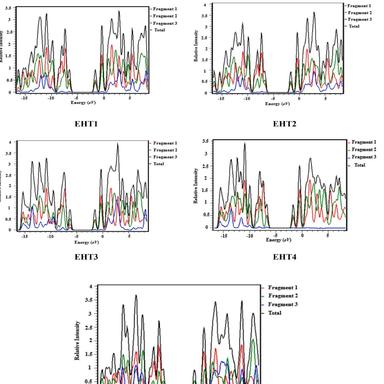
DOS plots of all the synthesized compounds (EHT1-EHT5).